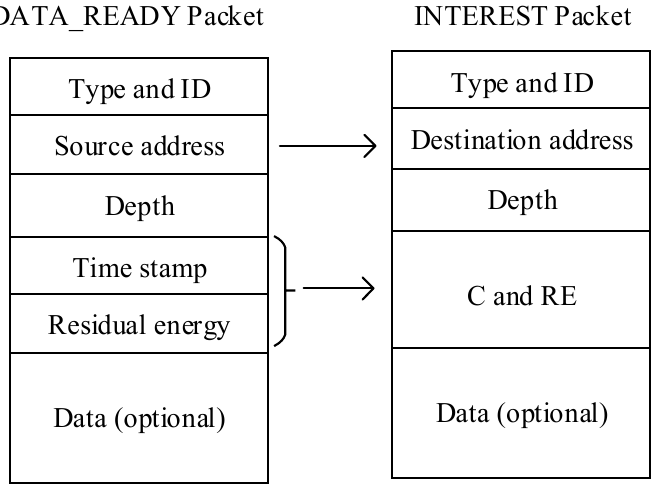
Figure 2. Packet structures of DATA_READY packet in data_ready phase and INTEREST packet in interest phase and their relationship.